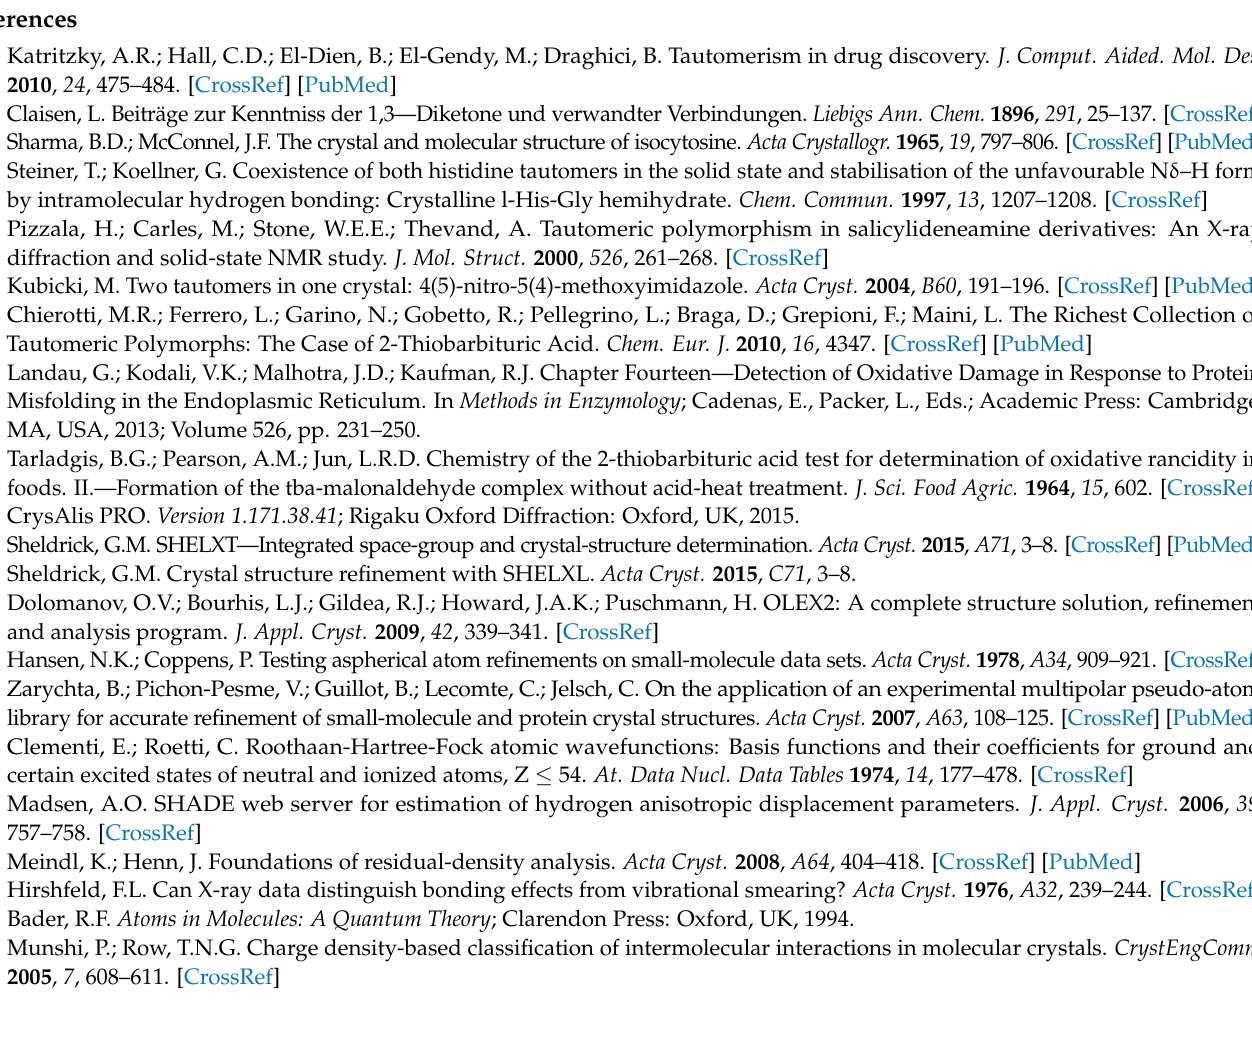
deformation density maps, Figure S3: Residual electron density maps, Table S1: Rigid bond test, Table S2: Bond critical points, Table S3: Bond critical points for intermolecular